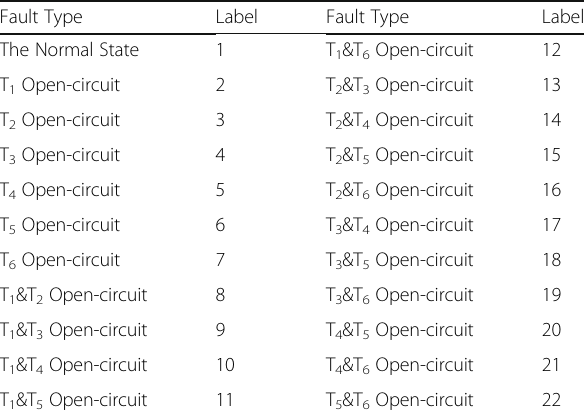
Table 1 Labels of Different Fault